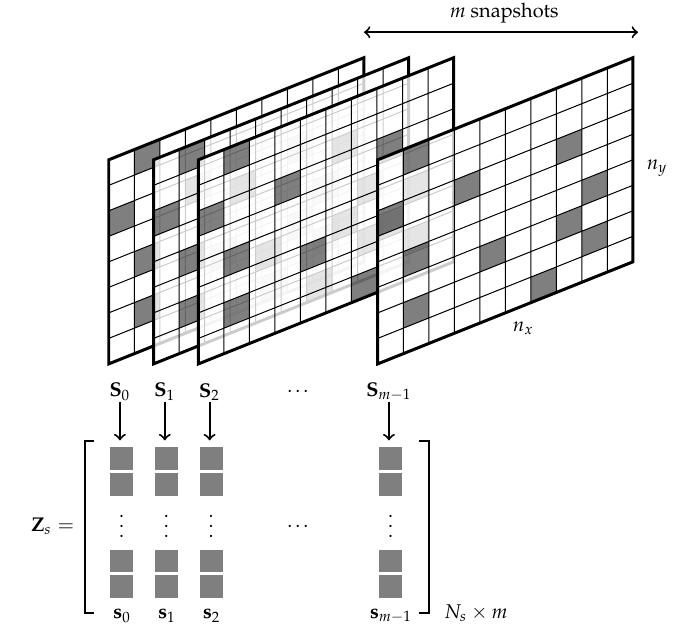
Figure 1. Schematic representation of the designated structure of the input data of DMDct algorithm where each snapshot S k is an n y × n x matrix of real values. The randomly-sampled points of each snapshot (colored in gray) are vectorized and represented as a real-valued data vector s k of length N s , where N s is the number of sampling points. The sampling mask remains the same for all